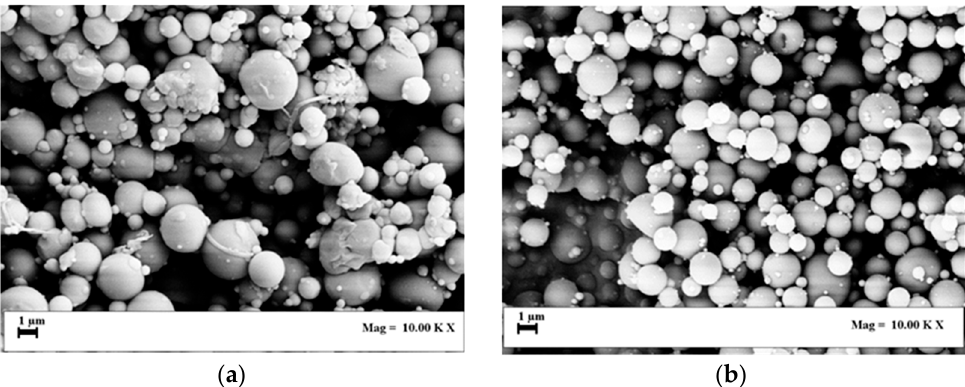
Figure 2. SEM images of PVP (1% w / w ) particles produced at ( a ) 80 bar and ( b ) 120 bar.